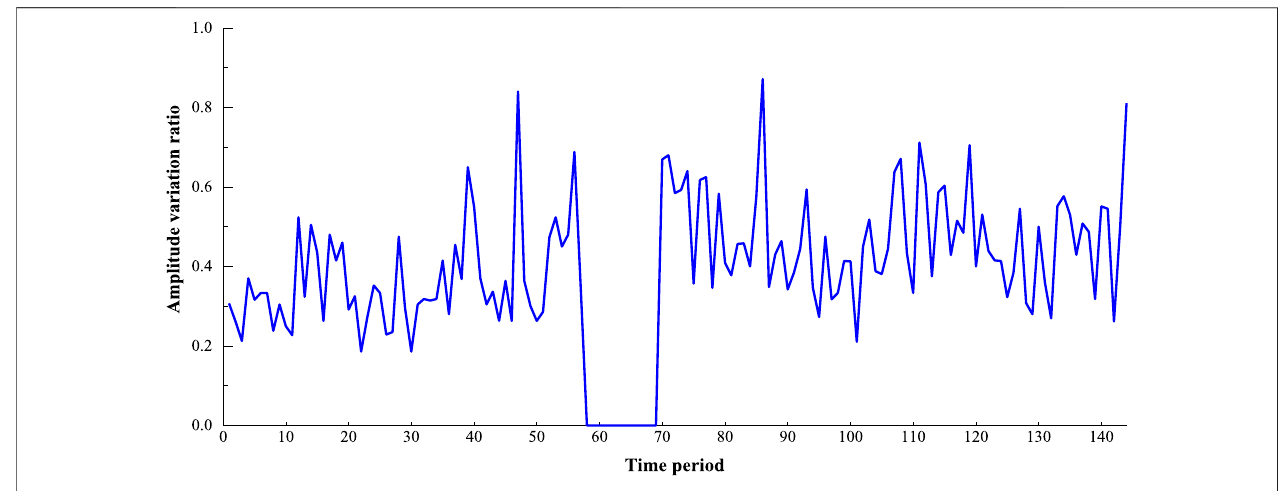
FIGURE 11 | Gas emission quantity amplitude variation ratio